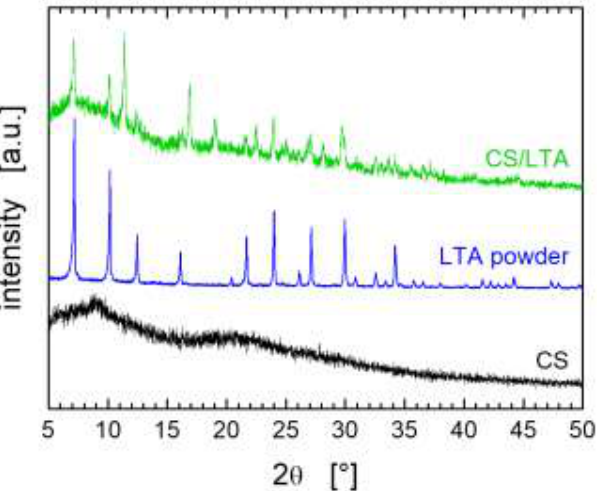
Figure 4. XRD patterns of CS, LTA powder, and hybrid CS/LTA sample at weight ratio equal to 1:1. The XRD patterns have been vertically shifted for the sake of